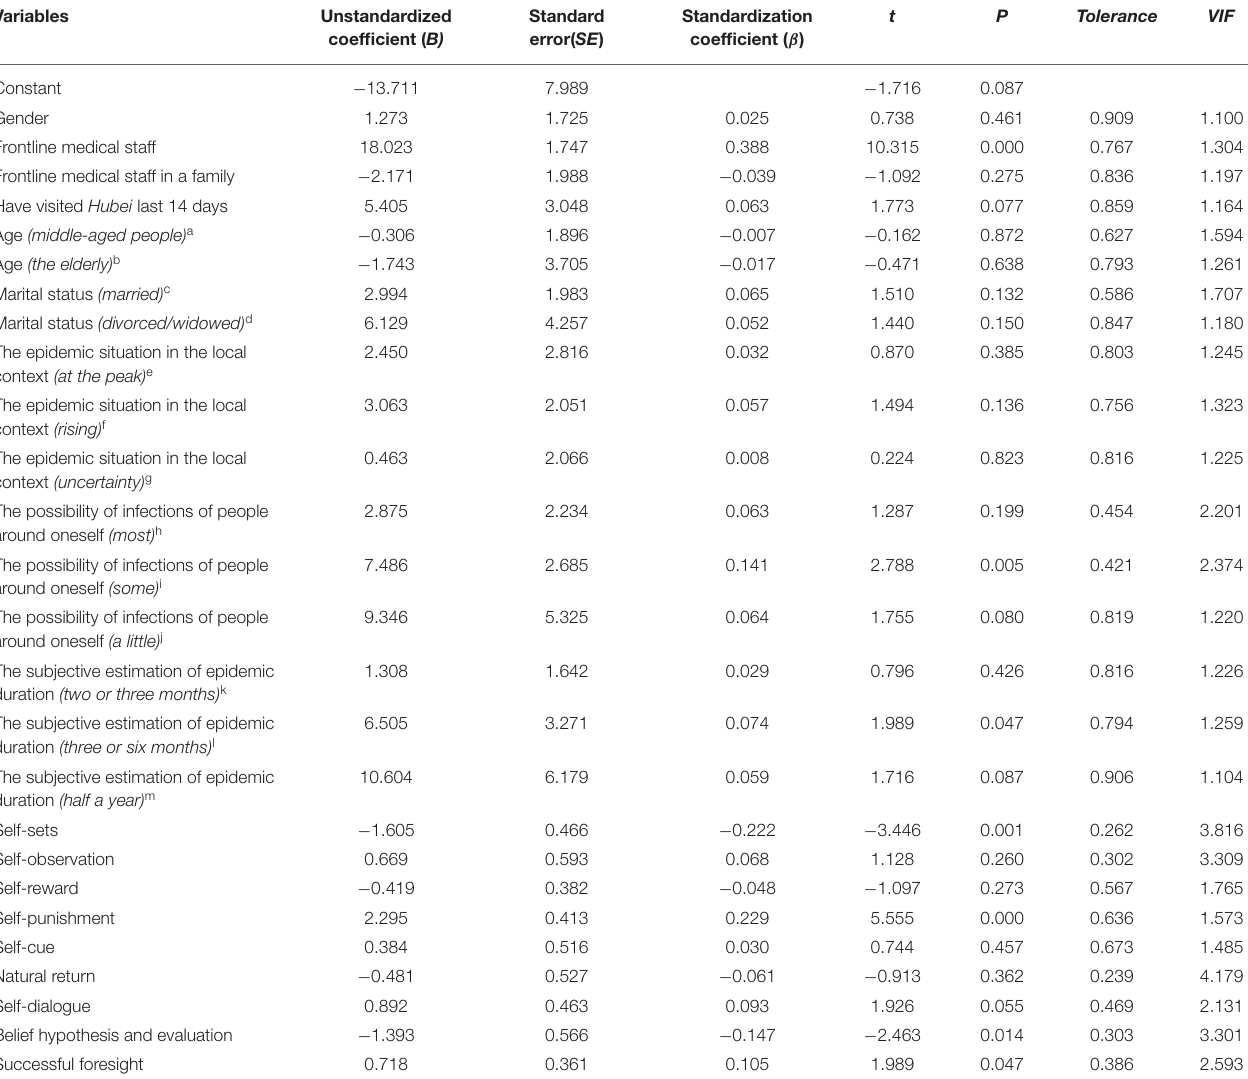
TABLE 3 | Hierarchical regression analysis of influencing factors of ASR in medics ( n =